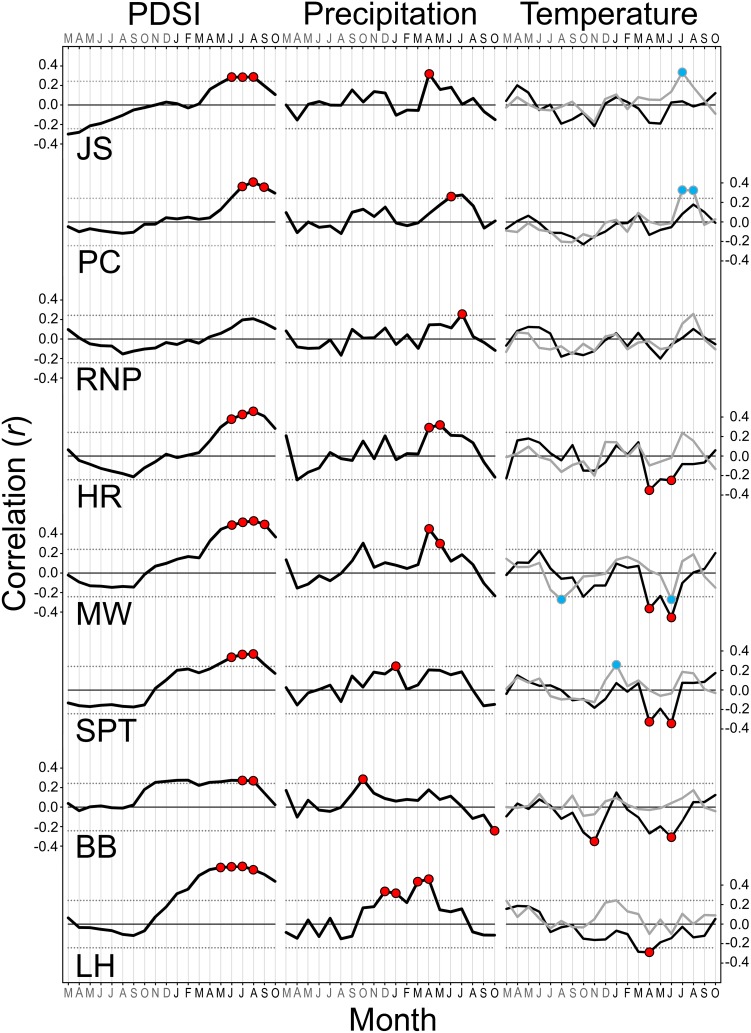
Summary of climate sensitivities for eight Sequoia sempervirens locations.Bootstrapped correlations and response functions of residual tree-ring chronologies against monthly Palmer Drought Severity Index (PDSI), precipitation, and maximum and minimum temperature conducted over a 114-year common period (1895–2008). Thicker black lines indicate correlation values. Thin dotted lines represent cutoff for statistical significance (P<0.01). Colored circles show months with significant correlations and response functions. Grey lines and blue circles represent minimum temperature. Letters indicate 20 months from March of previous year to October of current year. Locations arranged by latitude from north (top) to south (bottom).